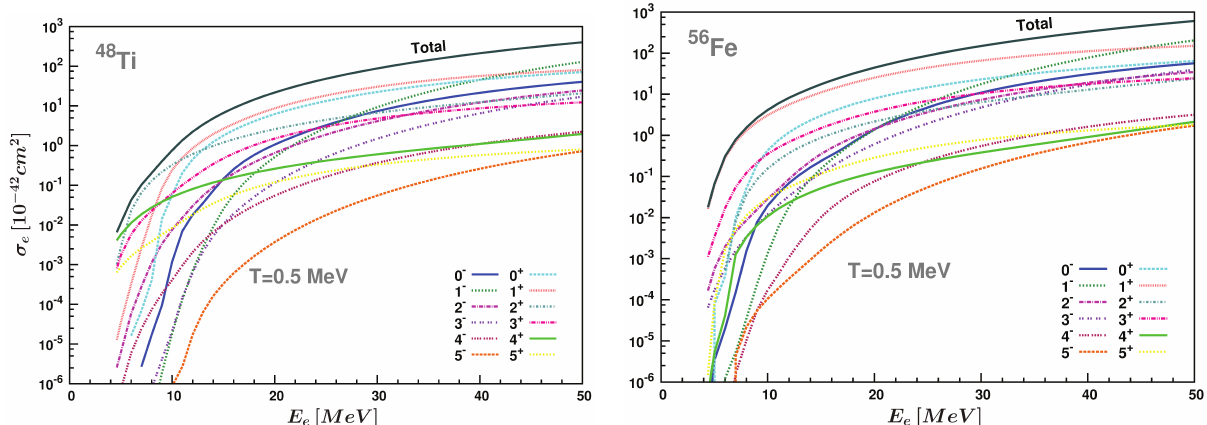
Figure 1. Electron-capture cross-sections for the parent nuclei 48 Ti and 56 Fe at high temperatures in the stellar environment (T = 0.5 MeV). Total cross-sections and the pronounced individual multipole channels for J π ≤ 5 ± are demonstrated as functions of the incident electron energy E e